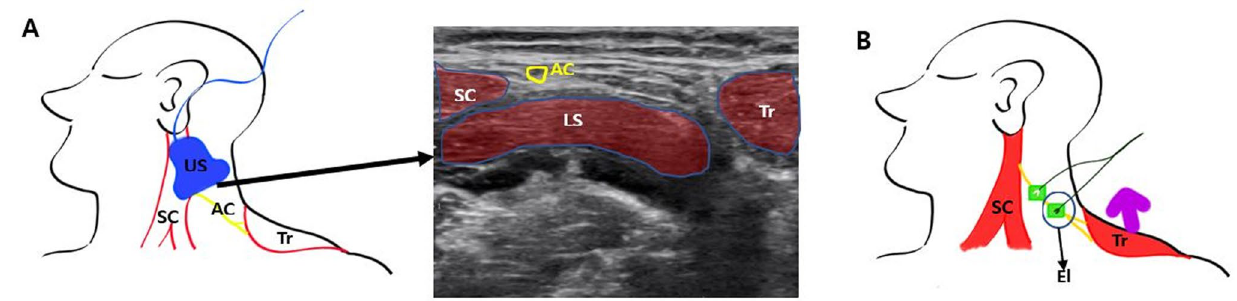
Figure 2. Illustrations and ultrasound image of methods for detection of the accessory nerve and the placement of the electrodes and transducer of the accelerometer in the trapezius muscle group (group T). A: The accessory nerve was confirmed by ultrasonography; the picture indicates the accessory nerve and surrounding muscles. B: The electrodes were placed over the accessory nerve. The purple arrow indicates a cranial direction of shoulder movement by electrical stimulation (shrug). The electrodes for acceleromyography were placed on the accessory nerve after the pathway was confirmed by ultrasonography. The transducer of the accelerometer was fixed at the left trapezius muscle at approximately 10 cm from the electrodes. SC: Sternocleidomastoid muscle, Tr: Trapezius muscle, AC: Yellow line, accessory nerve, US: Ultrasonography, El: Electrodes LS: Levator scapulae